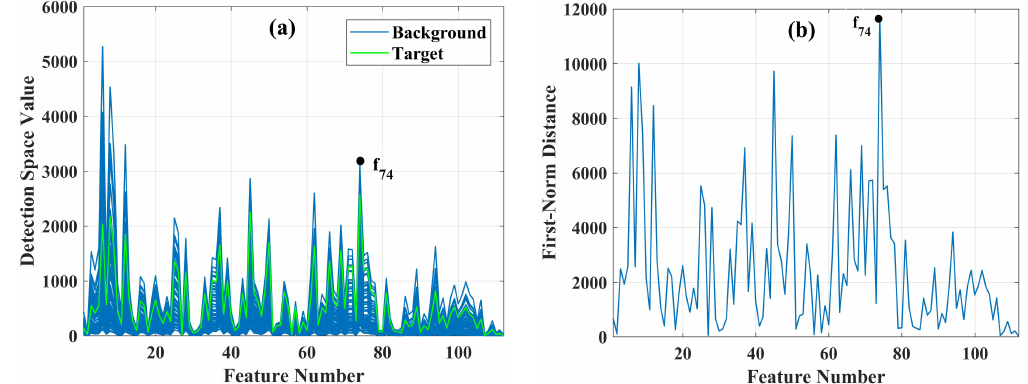
Figure 9. ( a ) The target 𝒕 and background 𝑪(cid:3561) spectra in the detection space (DS). ( b ) The sum of first-norm distances between the target and the cluster means obtained by the first-norm distance (FND) method for each feature in the full-dimensional DS. Feature ( 𝒇 (cid:2875)(cid:2872) ) is selected as the first optimal feature.